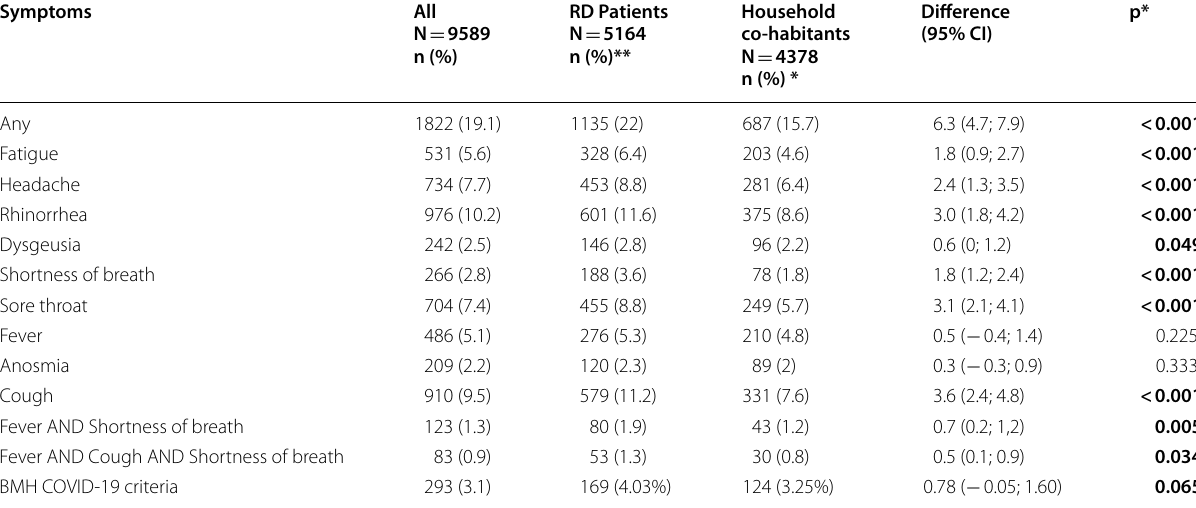
Table 3 Self‑reported influenza‑like illness symptoms and a COVID‑19 diagnosis in patients with rheumatic diseases and household contacts at baseline